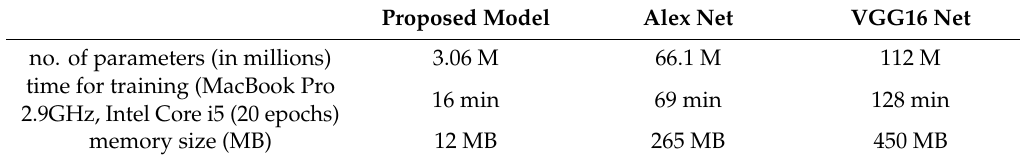
Figure 15. Performance comparison of di ff erent models based on precision, recall, and f1-score. Table 6. Parametric comparison with deep CNN